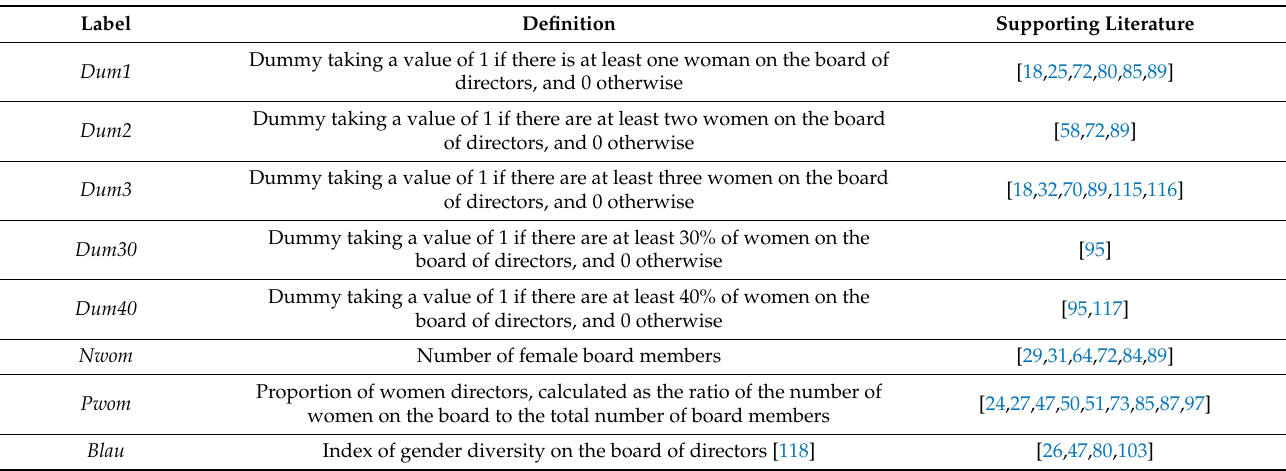
Table 4. Gender diversity